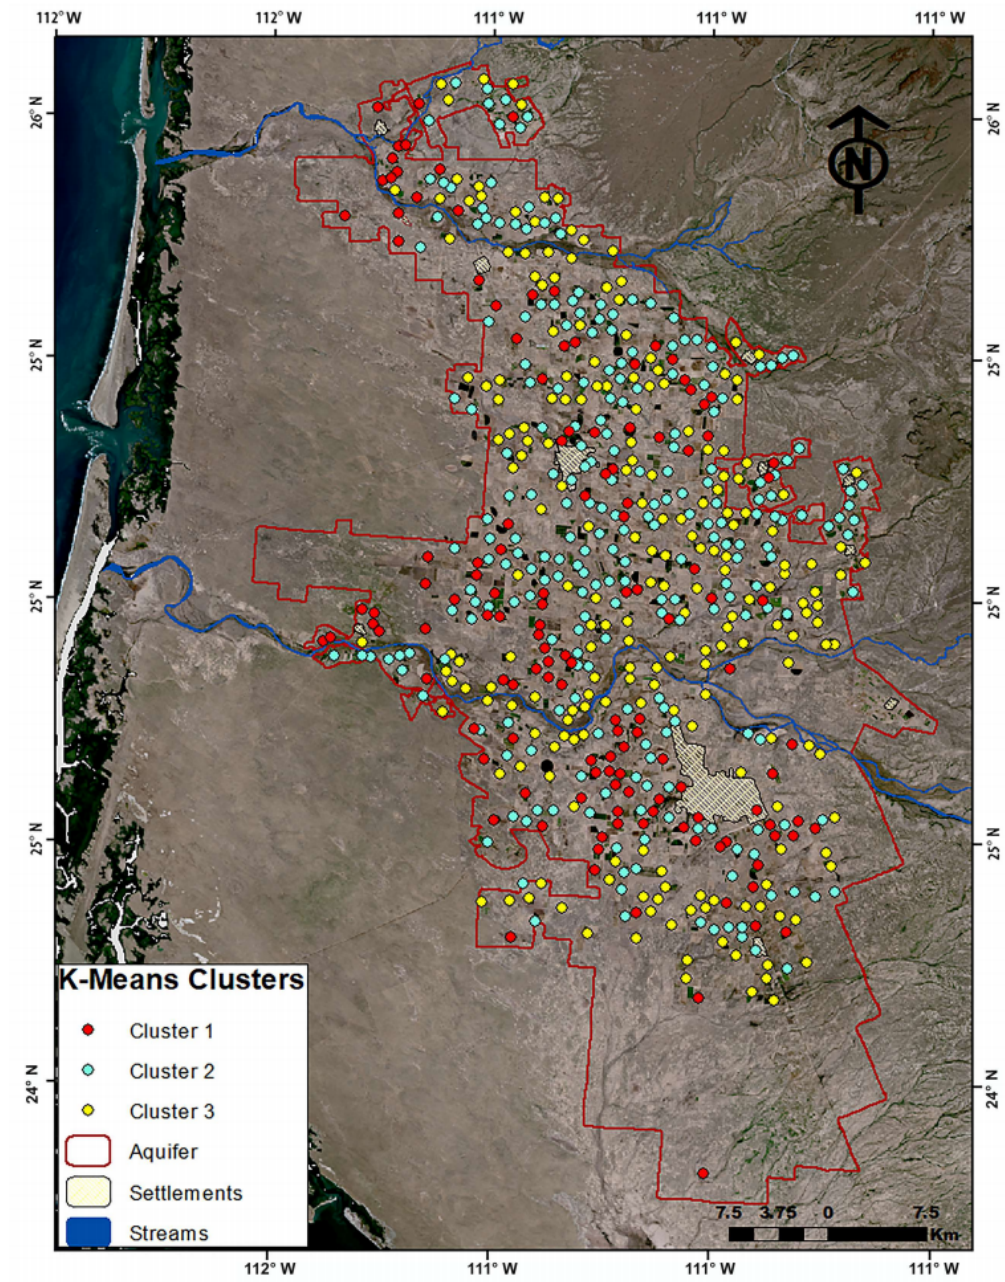
Figure 5. Spatial distribution of groups using K-means clustering on high dimensional